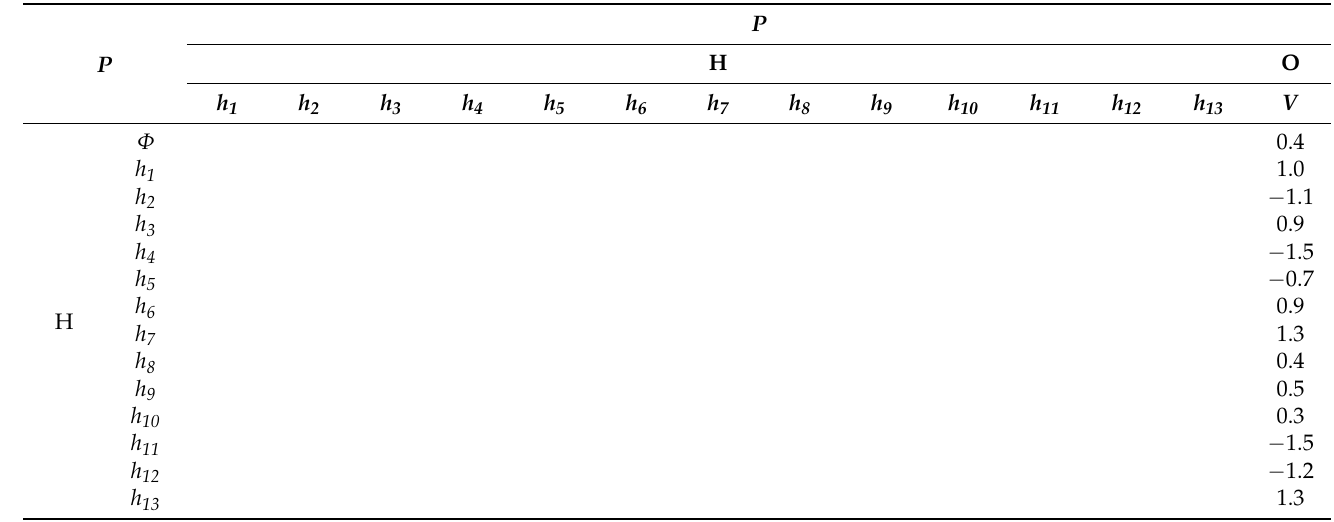
Table 5. Layer-to-layer connection weights for the predictive model of IC debonding.